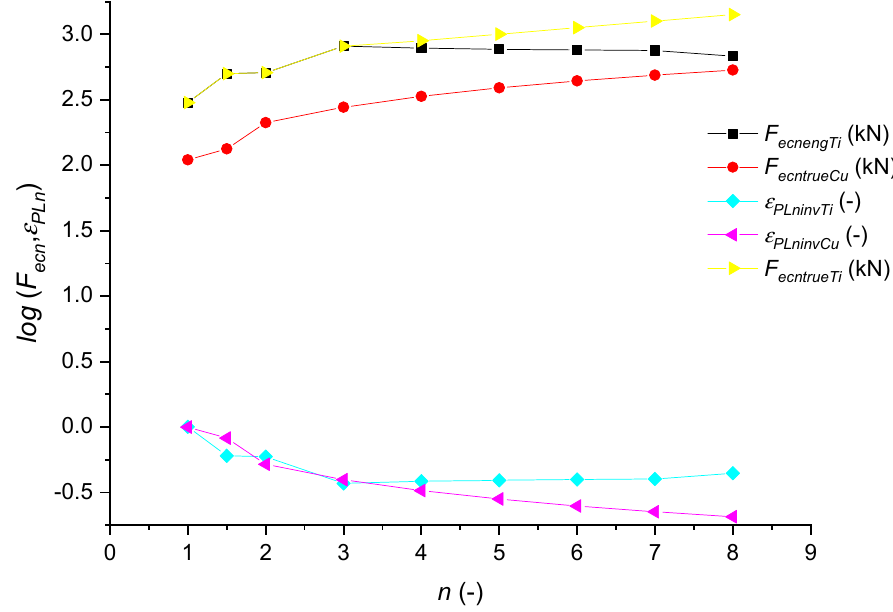
Figure 16. Comparison of force and relative deformation for materials Cu/Ti.